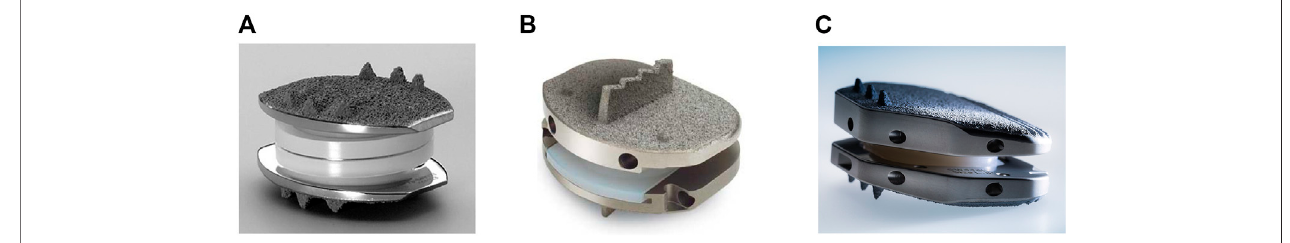
FIGURE 2 | Three intervertebral disc implants currently approved for use by the FDA including: (A) Charité III disc replacement (Depuy Spine) and (B) Prodisc-L (Centinel Spine) and (C) ActivL ® arti fi cial disc (Aesculap Implant Systems). Figures 2A,B reprinted with no alterations from (Kaner and Ozer, 2013) under Creative Commons Public Domain Dedication waiver (creativecommons.org/publicdomain/zero/1.0). Figure 2C (Aesculap ’ s activL ® Arti fi cial Disc product image) used with permission from Aesculap Implant Systems, LLC, Center Valley,